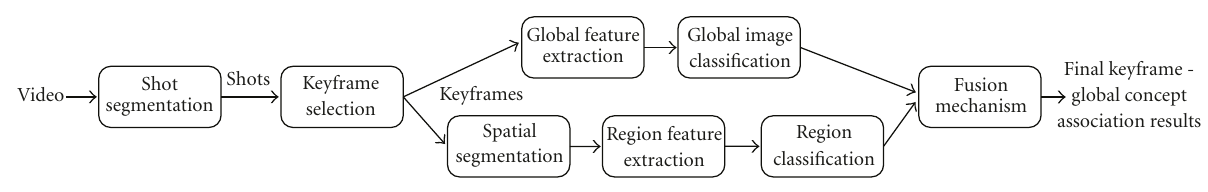
Figure 3: Overview of the visual classification